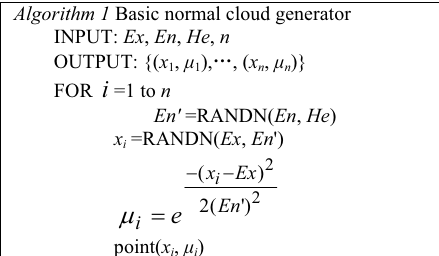
Algorithm 1 Basic normal cloud generator INPUT: Ex , En , He ,